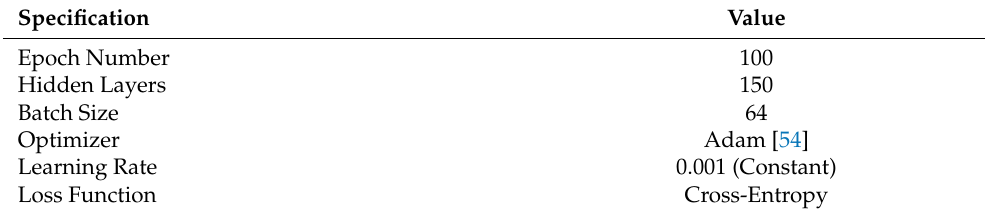
Figure 6. Neural Networks architectures used in this manuscript. The input shown represents a single feature window. ( a ) The CNN identifies correlations from the various features provided. ( b ) The LSTM network detects crucial temporal features. ( c ) The BiLSTM network has a similar operating mode as LSTM but with bidirectional LSTM layers. ( d ) The hybrid CNN-LSTM extracts temporal patterns using convolutional features from the CNN convolutional layer. Based on [53]. Table 7. Specifications for the use of the Deep Learning models depicted in Figure